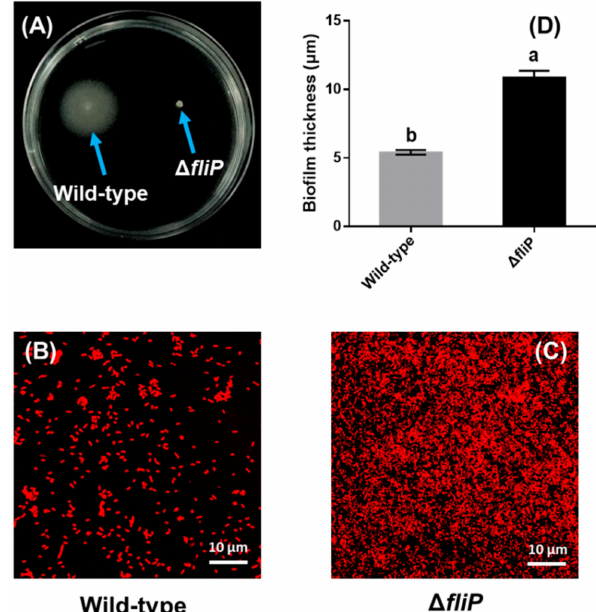
Figure 4. Biofilm formation of wild-type and ∆ fliP strains. ( A ) Swimming motility of wild-type and ∆ fliP strains; ( B ) the confocal laser scanning microscopy (CLSM) images of biofilms formed by the wild-type strain; ( C ) the CLSM images of ∆ fliP biofilms; ( D ) biofilm thickness statistical analysis of wild-type and ∆ fliP